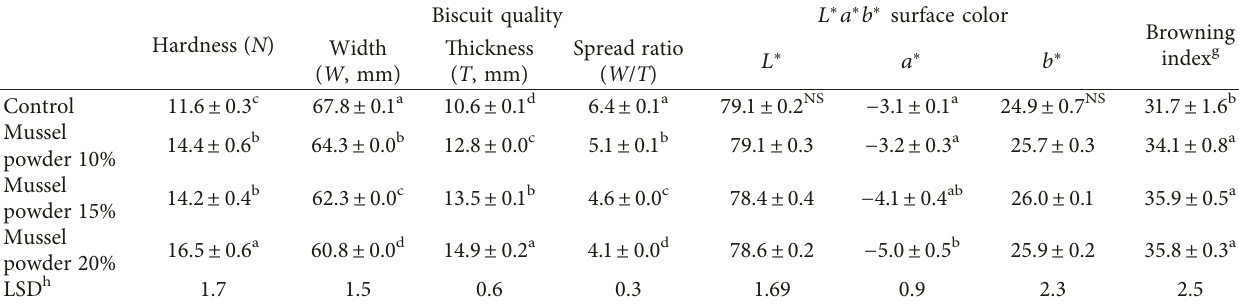
e Different superscripts (a, b, c, and d) in each column represent the significant difference (Duncan’s multiple range test, p < 0 . 05); values represent mean ± standard error; not significant (NS) � no significant differences were found ( p ≥ 0 . 05). f L ∗ is a measure of brightness from 0 � black to 100 � white; a ∗ indicates red/green color, with positive a ∗ value indicating redness and negative a ∗ value indicating greenness; b ∗ describes yellowness when the values are positive and blueness when the values are negative. g Browning index defines brown color. h LSD, least significant